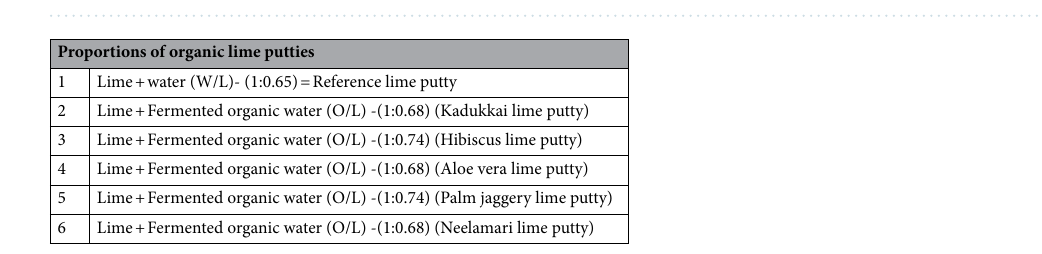
Table 1. Proportion of organic lime putties. (W/L): Lime to water ratio, (O/L): Lime to organic water.